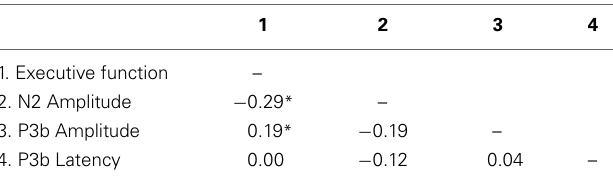
Table 3 | Inter-factor correlations extracted from the